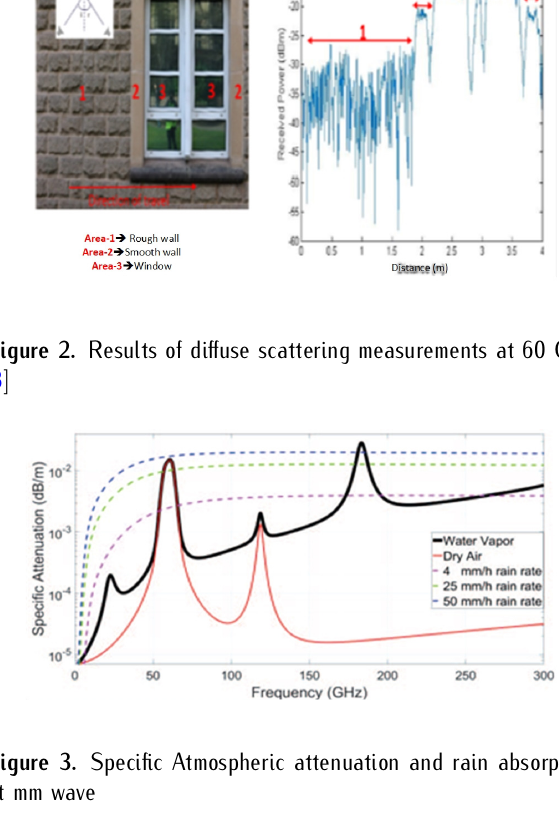
Figure 3. Specific Atmospheric attenuation and rain absorption at mm wave